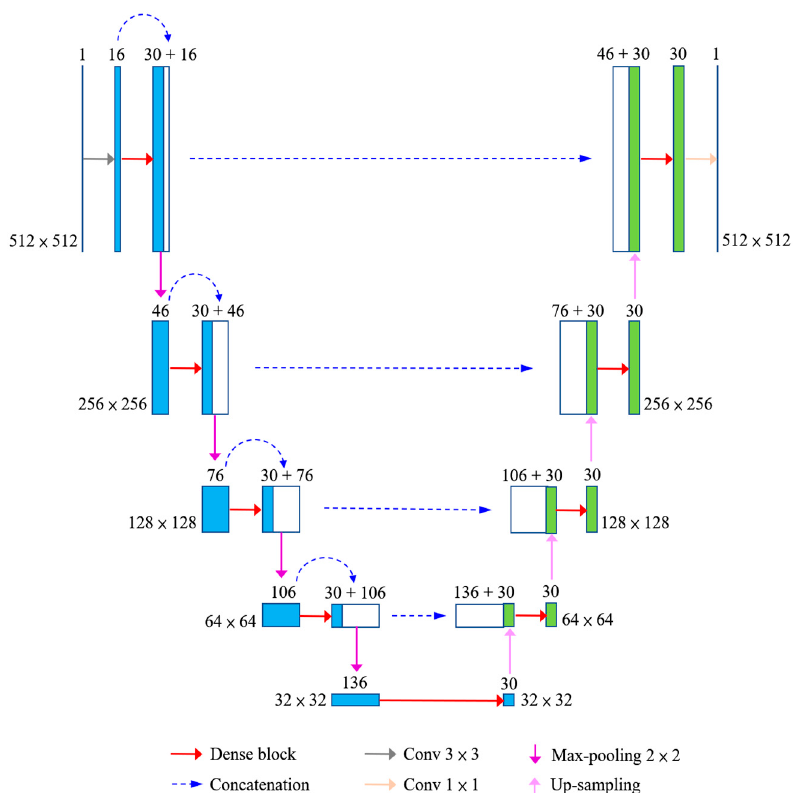
Figure 2. Network architecture of the proposed system.